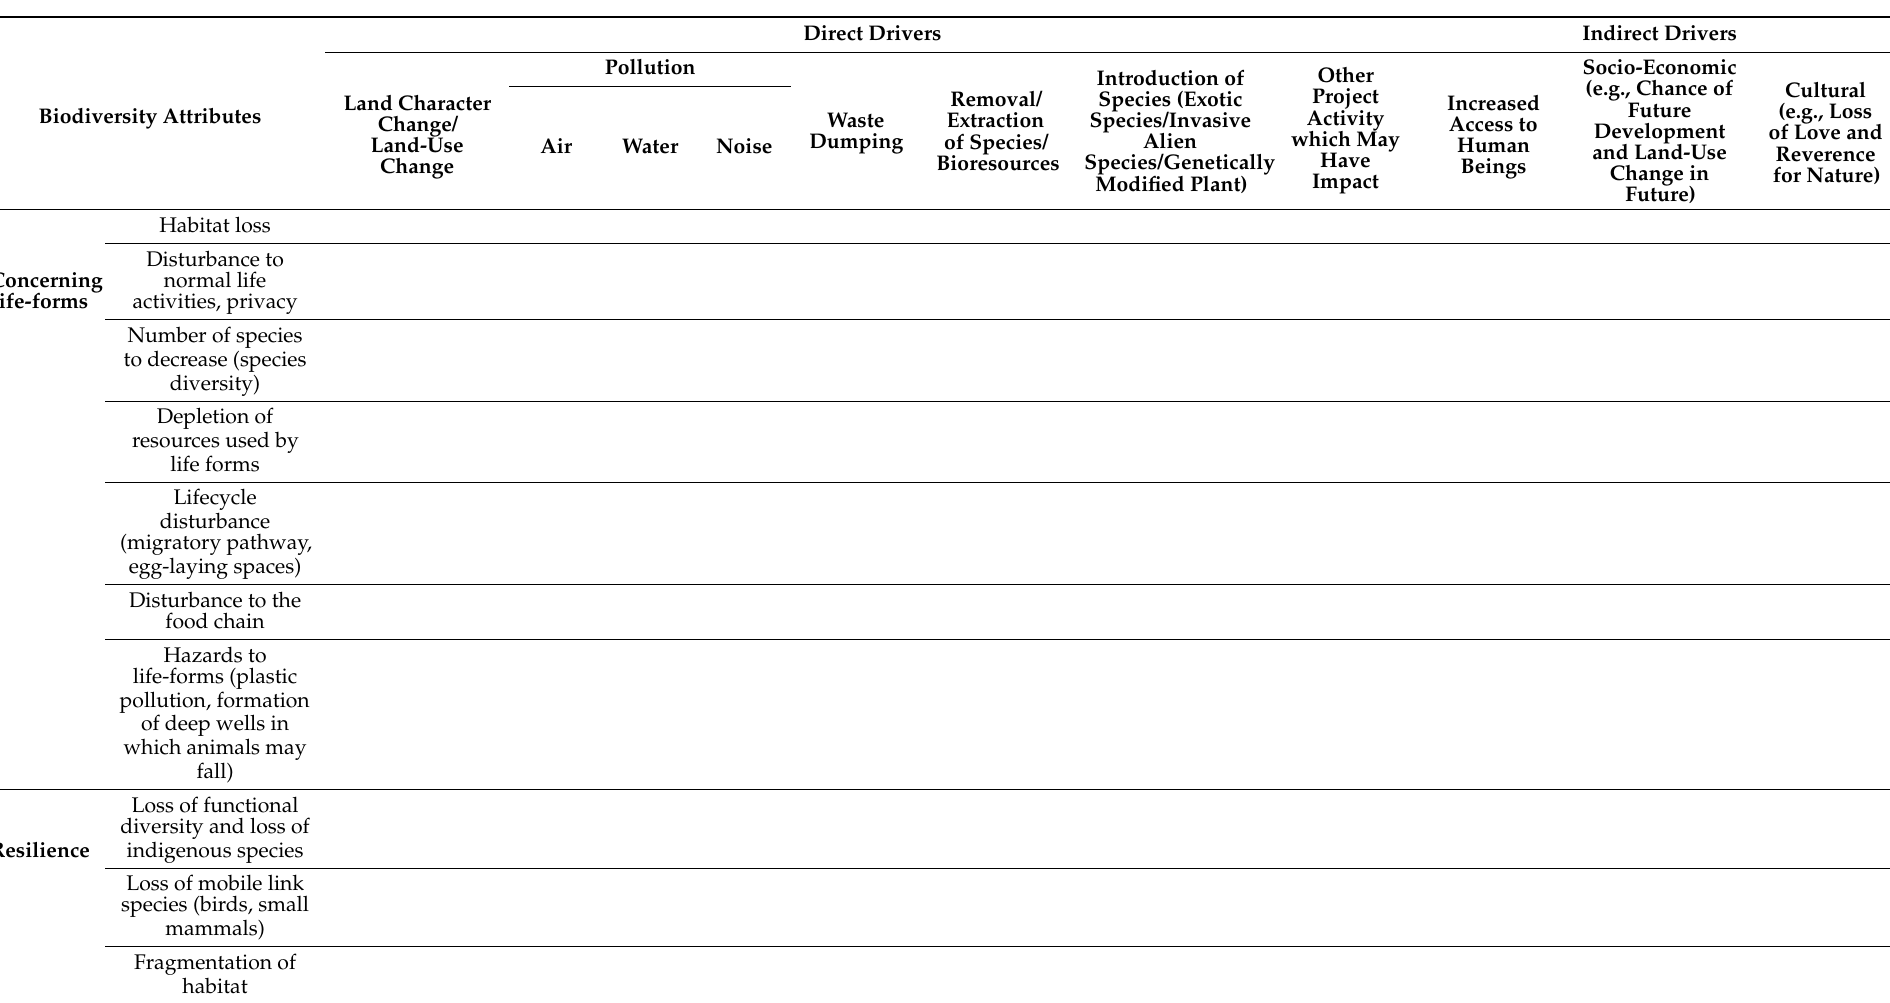
Table 3. Table for use of local people for assessment of adverse biodiversity impact from a proposed